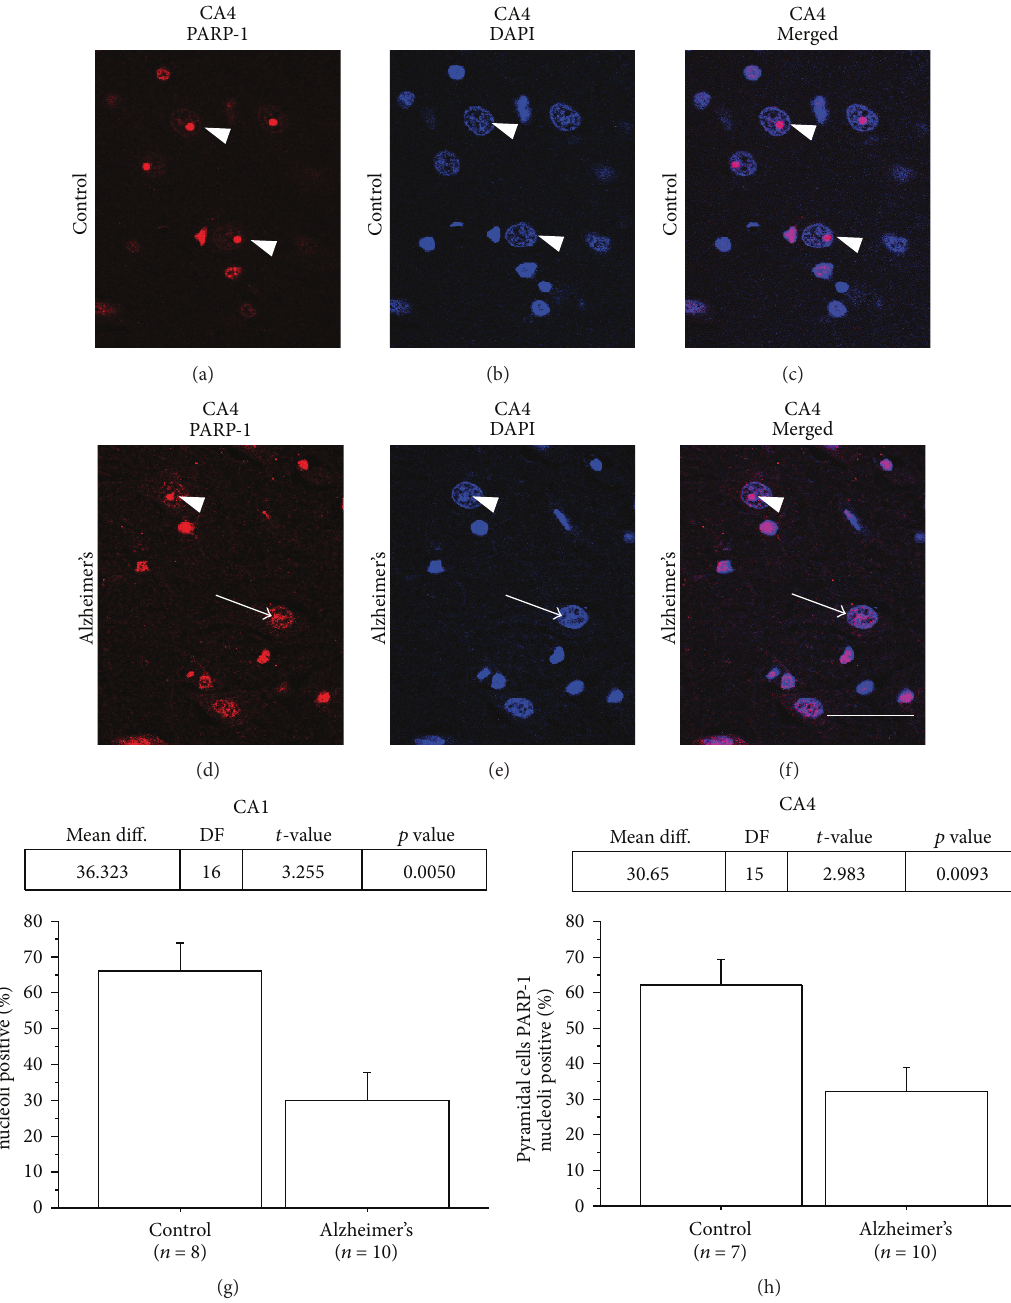
Figure 2: PARP-1 nucleolar immunoreactivity is altered in hippocampal pyramidal cells in AD brains. Representative confocal microscopy of PARP-1 immunostaining (red) with DAPI nuclear counterstaining (blue) of CA4 hippocampal pyramidal neurons. In controls brains (a–c) a high percentage of pyramidal cell nucleoli have intense and well- delineated PARP-1 staining (arrowheads). In contrast, in AD brains (d–f), the percentage of intensely stained and well-delineated nucleoli is less than in the controls and there is a more dispersed pattern with weak label intensity ((d) and (f), arrow). ((g) and (h)) The percentage of CA1 (g) and CA4 (h) hippocampal pyramidal neurons with PARP-1 positive nucleoli staining was less in AD cases compared to controls. (Control, 𝑛 = 8 and 𝑛 = 7 for CA1 and CA4, resp.; AD, 𝑛 = 10 for both CA1 and CA4; ∗ 𝑝 < 0.05 .) Scale bar = 25 𝜇